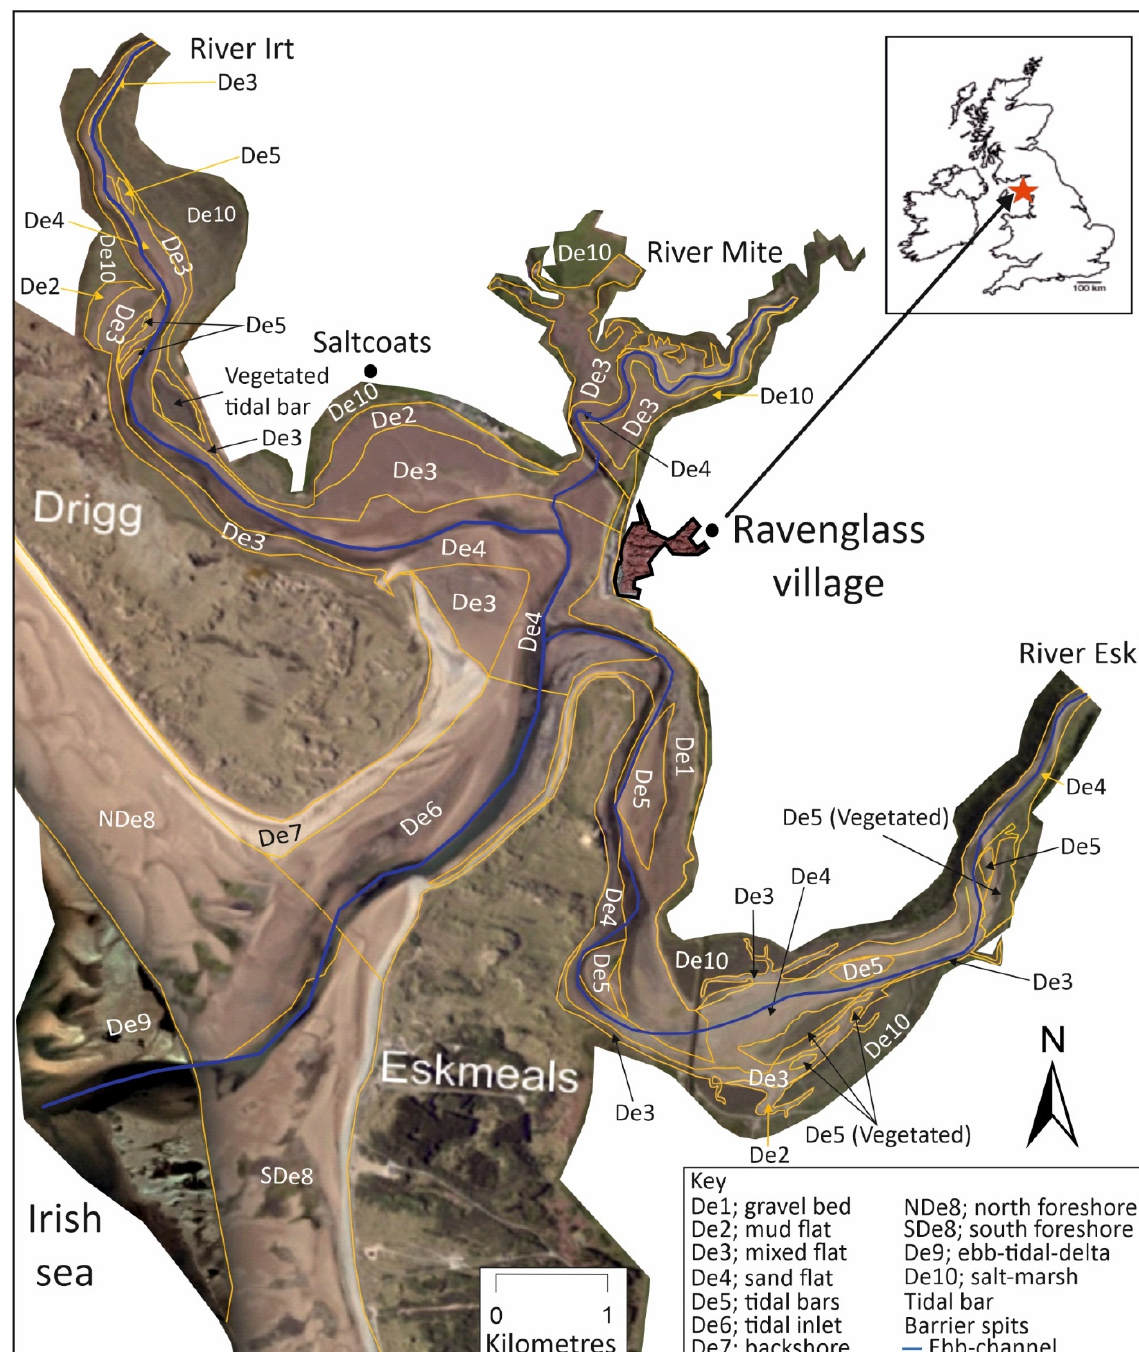
Figure 2. Distribution of estuarine sub-depositional environments mapped across the Ravenglass Estuary. These sub-depositional environments are labelled; De1, gravel bed; De2, mud flat; De3, mixed flat; De4, sand flat; De5, tidal bars; De6, tidal inlet; De7, backshore; De8, foreshore (northern and southern sites); De9, ebb-tidal delta; and De10, salt marsh.